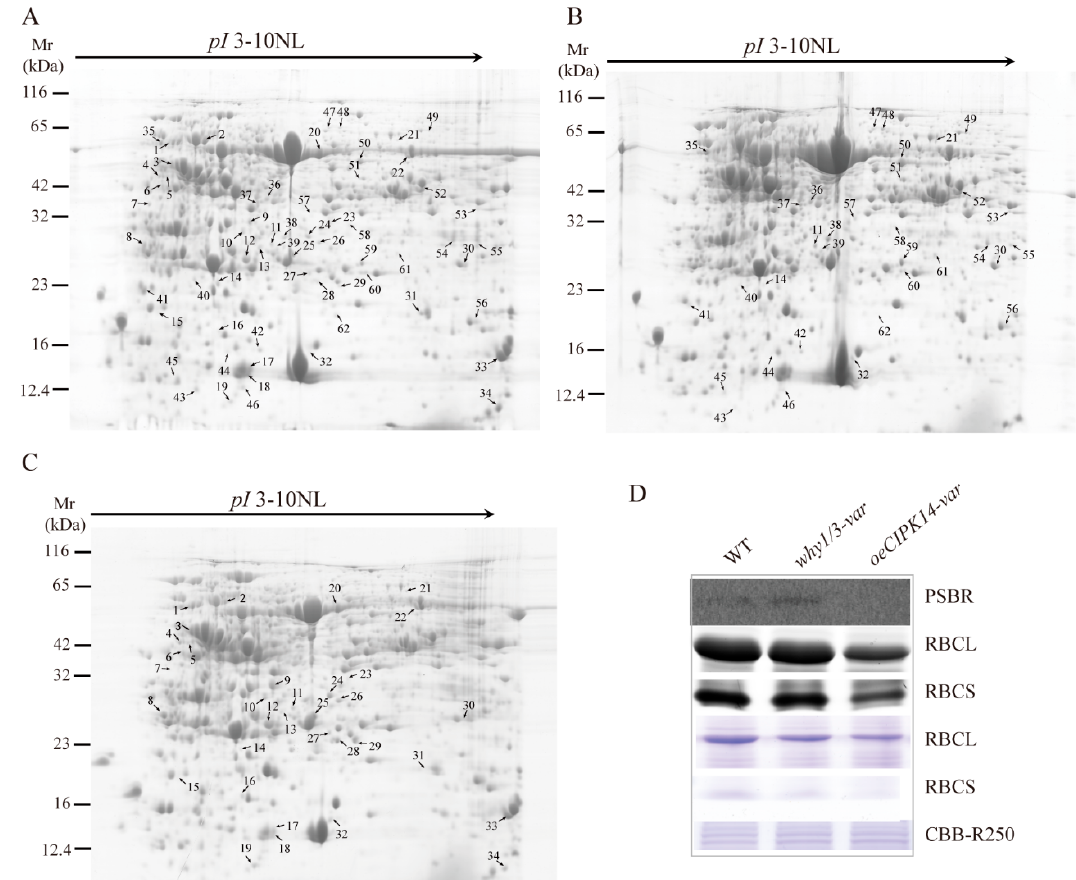
Figure 1. 2-DE and immunoblot analysis of total proteins extracted from rosette leaves of WT and two variegated mutants. ( A – C ) Representative 2-DE gel images of WT ( A ); why1/3-var ( B ); and oeCIPK14-var ( C ). An equal amount (1.5 mg) of total proteins was loaded on each IPG strips (3–10 NL). The spot numbers indicated proteins that showed significant changes between WT and two variegated mutants. ( D ) The changing of protein abundance selected from 2-DE were confirmed by western blot and CBB R250 staining. The immunoblot analysis is performed using antibodies against RBCL, RBCS, and PSBR. CBB R250 staining shows RBCL and RBCS protein amount and the same amount of loading proteins.